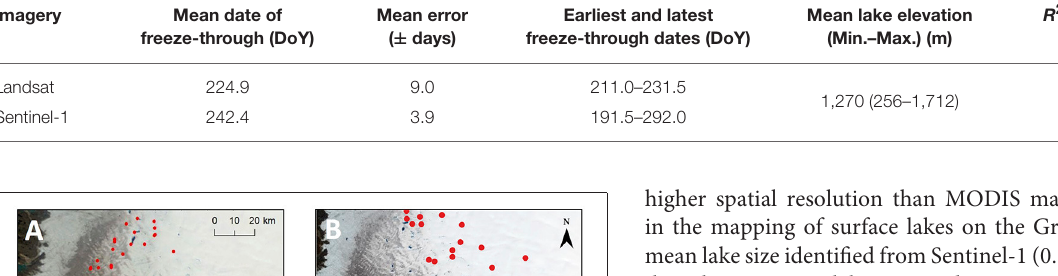
TABLE 3 | Results from the surface lake freeze-through detections of the Sentinel-1 and the Landsat data. DoY refers to day of year (in 2015). Imagery